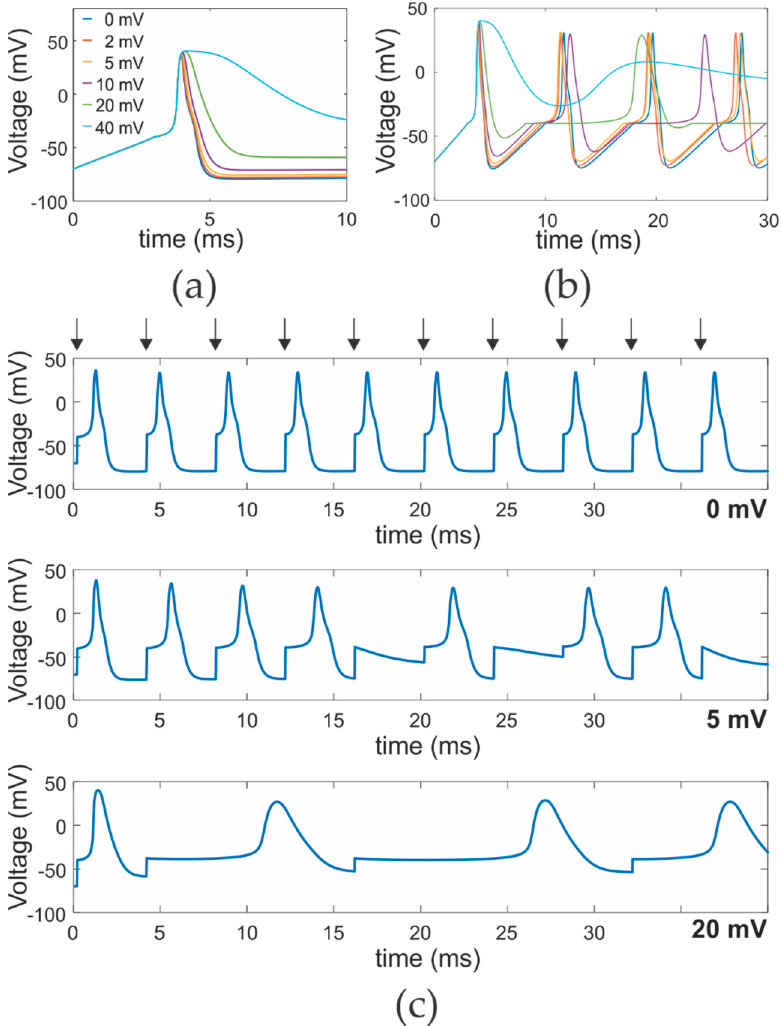
Figure 4. ( a ) Simulation of a single action potential according to a Hodgkin and Huxley model, where the voltage dependence of the voltage-gated potassium channels has been shifted by the amount indicated in the legend. ( b ) Simulation of a train of action potentials in response to continuous current stimulation (colors as in ( a )). ( c ) Simulation of a train of action potentials in response to a train of current stimulations (indicated by arrows on top). Kv activation has been shifted by 0 mV (top), 5 mV (center) and 20 mV (bottom).